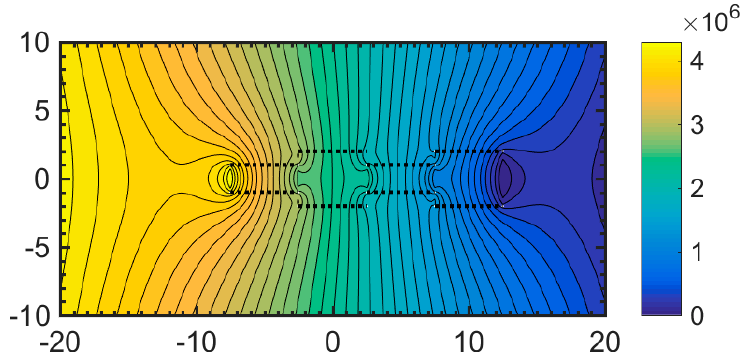
Figure 4. Pressure field (Pa) calculated by taking the real part of the complex potential for configuration in Figure 3c. The increase in pressure is localized in the pore throats. Narrower pore diameters show higher pressure gradients, as expected. The macroscopic permeability is 600 nD, viscosity as 1 cP, far field flow velocity is 1.5 m/year, and pore strengths is 225 m 4 /year. Length units are scaled in μ m (both x-axis and y-axis).